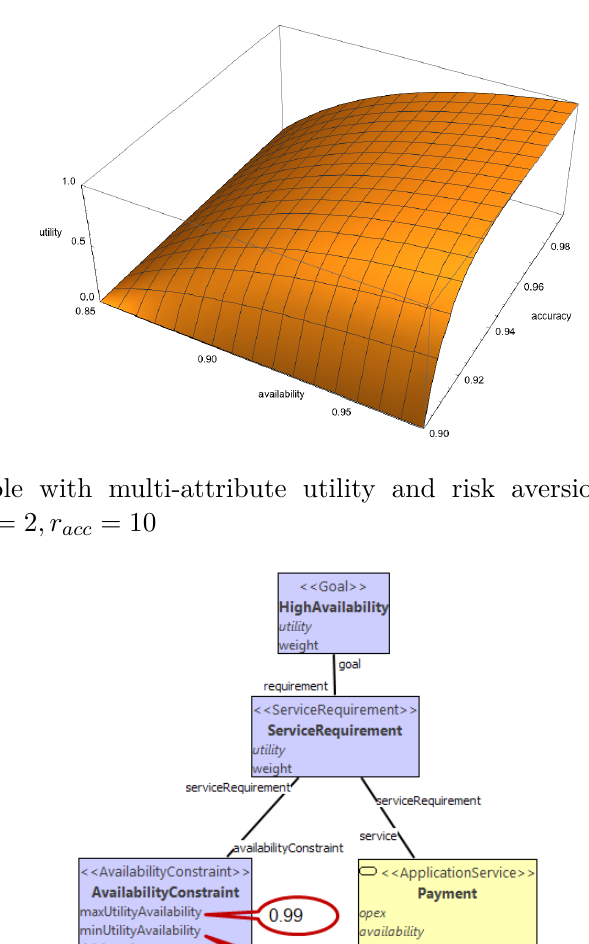
Figure 11. A simple MAPL utility